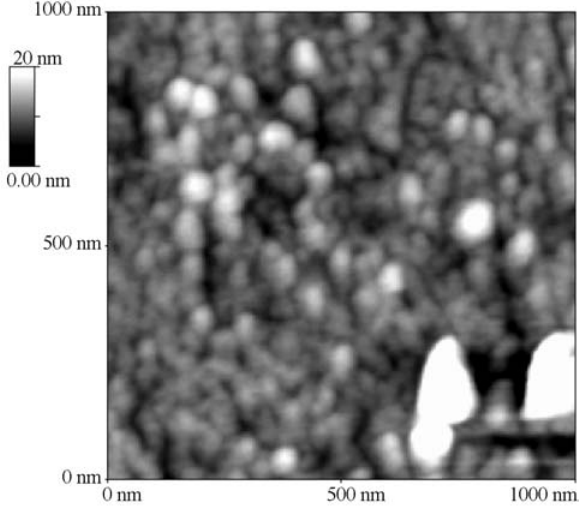
Figure 4. AFM image of the top surface of the PSf modified by argon plasma, 5 W, 10 min. R a = 1.2